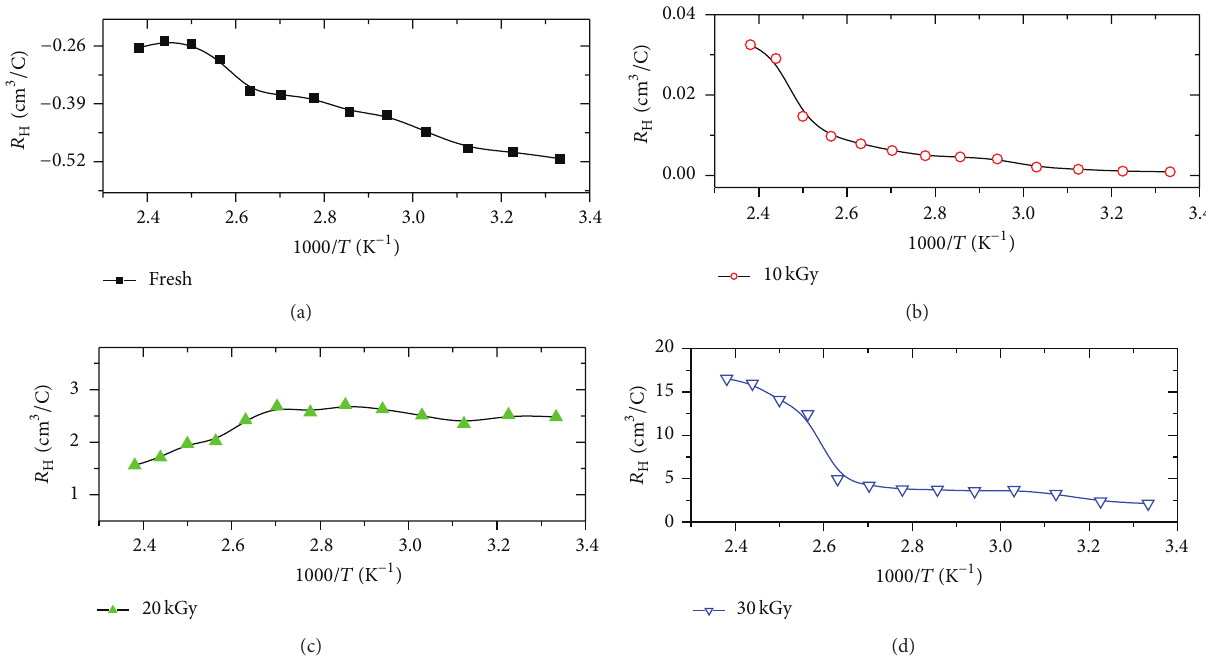
Figure 2: Temperature dependence of Hall coefficient, 𝑅 different